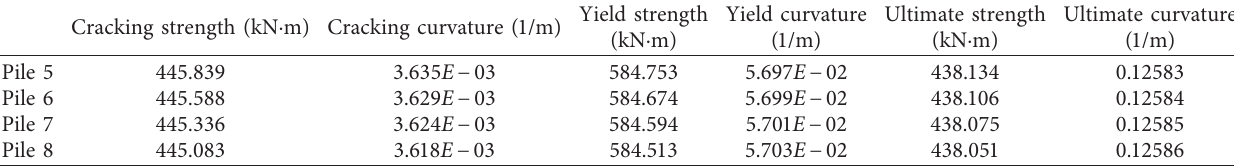
Table 16: Cracking, yield, and ultimate strengths and corresponding curvature values of piles